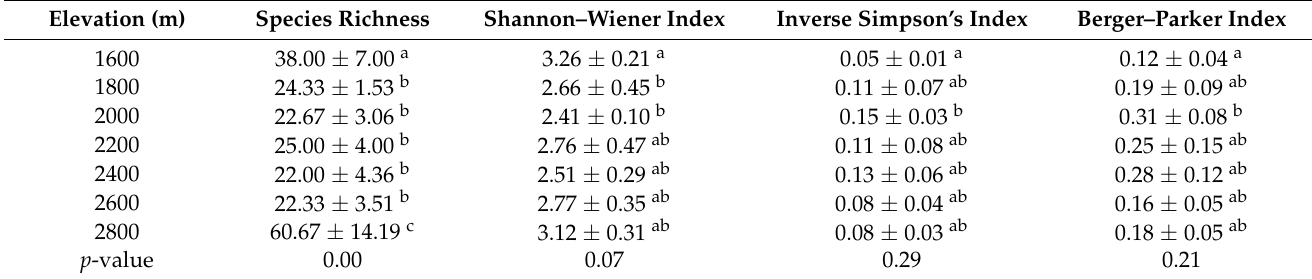
Table 3. The Hill numbers of insect species composition and diversity in typical vegetation community ecosystems along altitudinal gradient of the Guandi